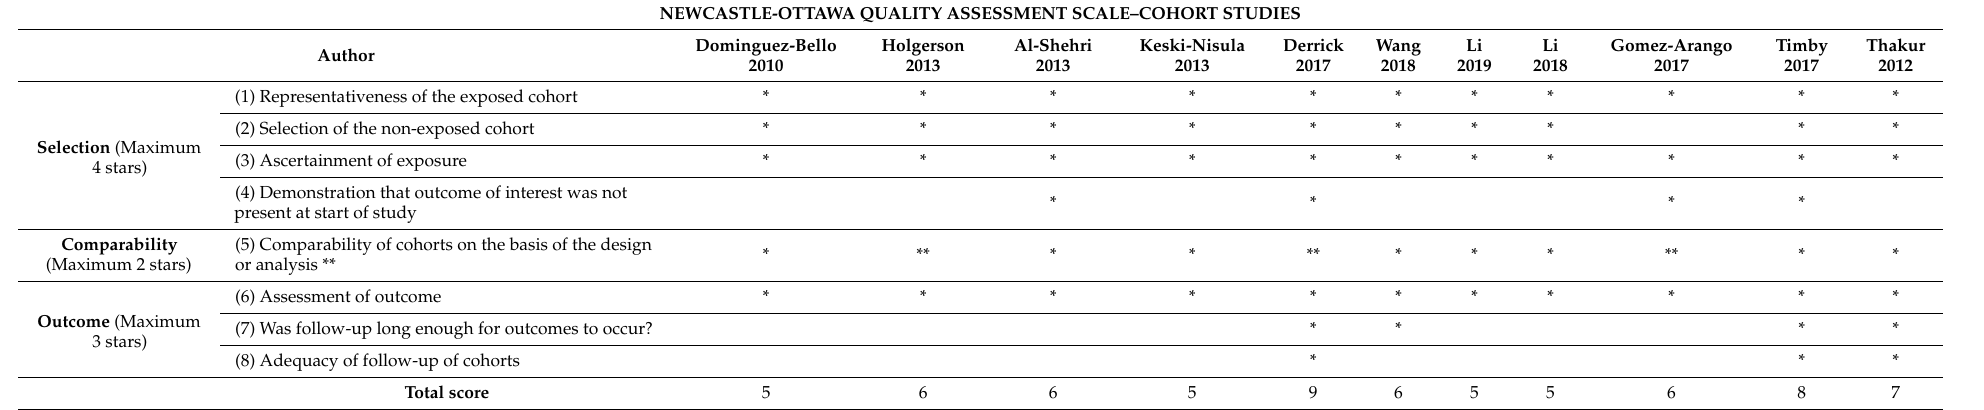
Table 2. Newcastle–Ottawa quality assessment scale for cohort